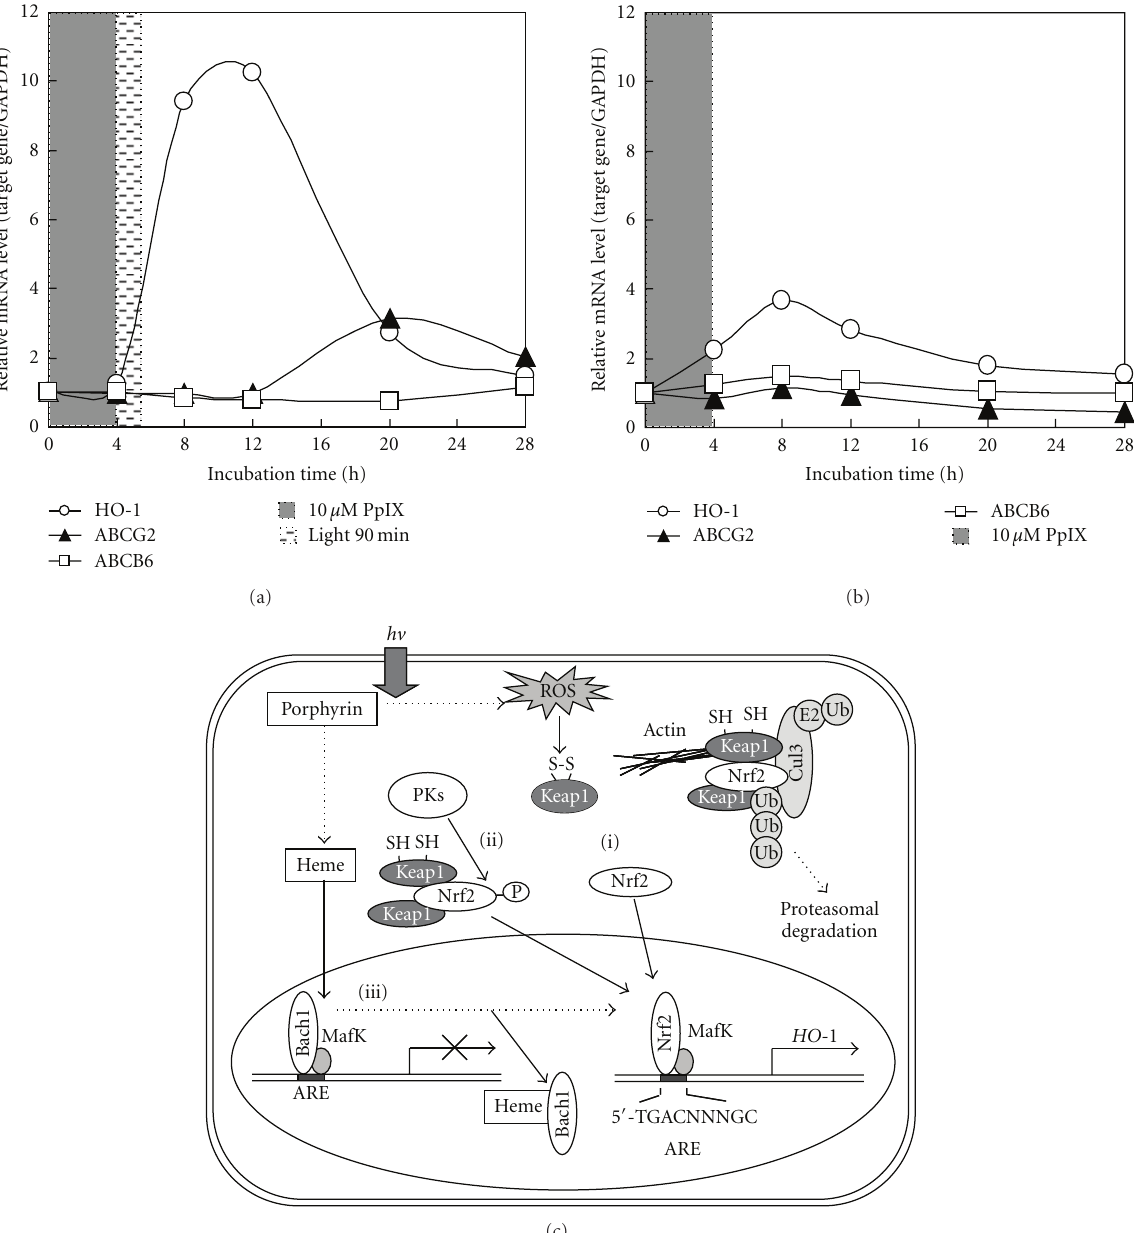
Figure 3: (a) Time courses of changes in the mRNA levels of heme oxygenase-1 (HO-1), ABCG2, and ABCB6 in HepG2 cells incubated with protoporphyrin IX (PpIX) and exposed to visible light. In dark conditions, HepG2 cells (1 × 10 6 cells) were first incubated with 10 μ M PpIX in Dulbecco’s modified Eagle’s medium at 37 ◦ C under 5% CO 2 gas for 4 hours. Thereafter, the incubation medium was replaced with fresh incubation medium. Cells were then exposed to visible light for 90 min, where cell culture dishes containing HepG2 cells were placed on a light viewer (Hakuba Model 5700) in an incubation chamber (37 ◦ C, 5% CO 2 ). Cells were subsequently incubated in the dark at 37 ◦ C under 5% CO 2 gas for 22.5 hours. The whole incubation was performed for a total of 28 hours, as indicated in the figure. (b) As the control experiments without light exposure, HepG2 cells (1 × 10 6 cells) were incubated with 10 μ M PpIX in the same way as described above. PCR primers to quantitatively measure mRNA levels of HO-1, ABCG2, ABCB6, and GAPDH are described in [44]. (c) Schematic illustration for the activation of Nrf2 via three di ff erent pathways ((i), (ii), and (iii)). Pathway (i), under homeostatic conditions, Nrf2 is sequestered in the cytoplasm by the Keap1-Cul3 complex and rapidly degraded in a ubiquitin-proteasome-dependent manner. After an oxidative challenge (e.g., 1 O 2 ), oxidation of two reactive cysteine residues of Keap1 inhibits the ubiquitination reaction of Nrf2 mediated by the Keap1-Cul3 complex, which results in both cytoplasmic accumulation and nuclear translocation of Nrf2. Pathway (ii), activation of Nrf2 is mediated by protein kinases (PKs), such as p38 MAPK , PI3K, PERK, and PKC. Pathway (iii), under normal conditions, the chromatin structure of HO-1 is in a preactivation state, but transcription is repressed by Bach1. Heme binds to Bach1, inhibiting its DNA binding activity and inducing its nuclear export. In the nuclei, the activated Nrf2 dimerizes with small Maf nuclear protein for e ff ective binding to the ARE consensus sequence in the promoter region of the HO-1